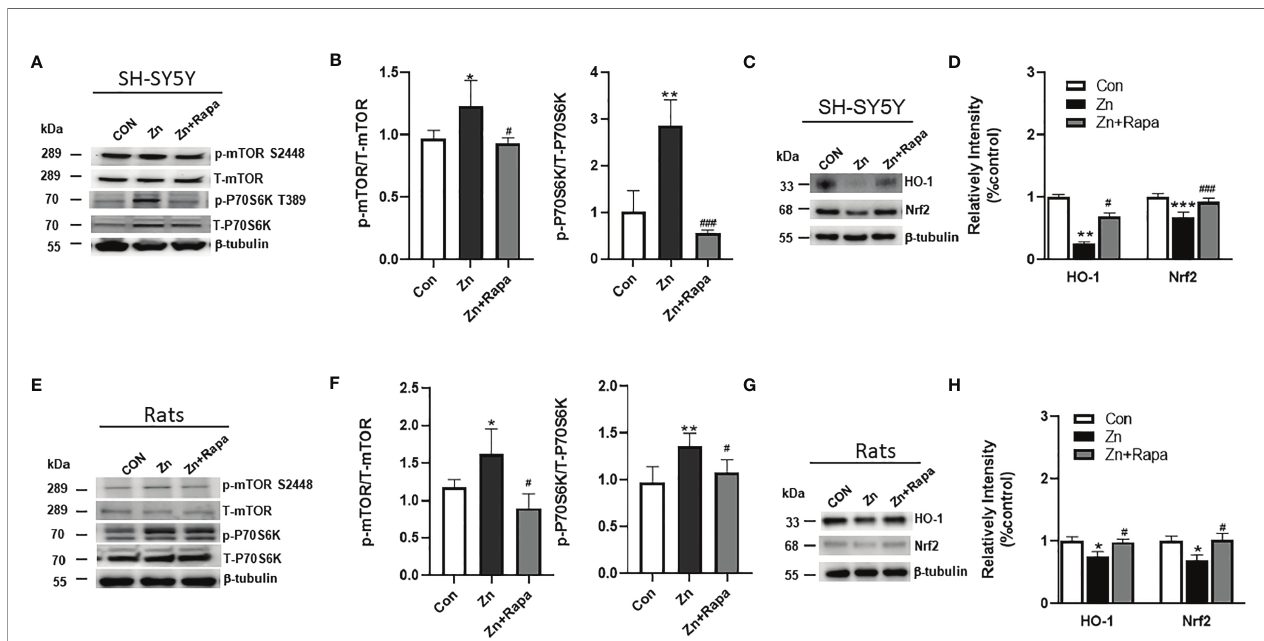
FIGURE 1 | Effects of rapamycin on the expression of mammalian target of rapamycin (mTOR)/ribosomal S6 protein kinase (P70S6K) and nuclear factor erythroid 2-related factor-2 (Nrf2)/heme oxygenase-1 (HO-1) signaling pathways in zinc-treated SH-SY5Y cells and rats. (A, B) Representative blots and quanti fi cation of the expression ratio of p-mTOR S2448/T-mTOR and p-P70S6K T389/T-P70S6K in SH-SY5Y cells of the control, zinc, and zinc+rapamycin groups. n = 3 cell experiments per group. (C, D) Representative blots and quanti fi cation of the expression levels of HO-1 and Nrf2 were detected in cells of the control, zinc, and zinc +rapamycin groups. n = 3 cell experiments per group. (E, F) Representative blots and quanti fi cation of the expression ratio of p-mTOR S2448/T-mTOR and p- P70S6K T389/T-P70S6K in rats in the control, zinc, and zinc+rapamycin groups. n = 4 rats per group in the same membrane. (G, H) Representative blots and quanti fi cation of the expression levels of HO-1 and Nrf2 in rats in the control, zinc, and zinc+rapamycin groups. n = 4 rats per group in the same membrane. Quanti fi cations of the blots were normalized to b -tubulin. *p < 0.05, **p < 0.01, ***p < 0.001 vs. control group; #p < 0.05, ###p < 0.001 vs. zinc+rapamycin